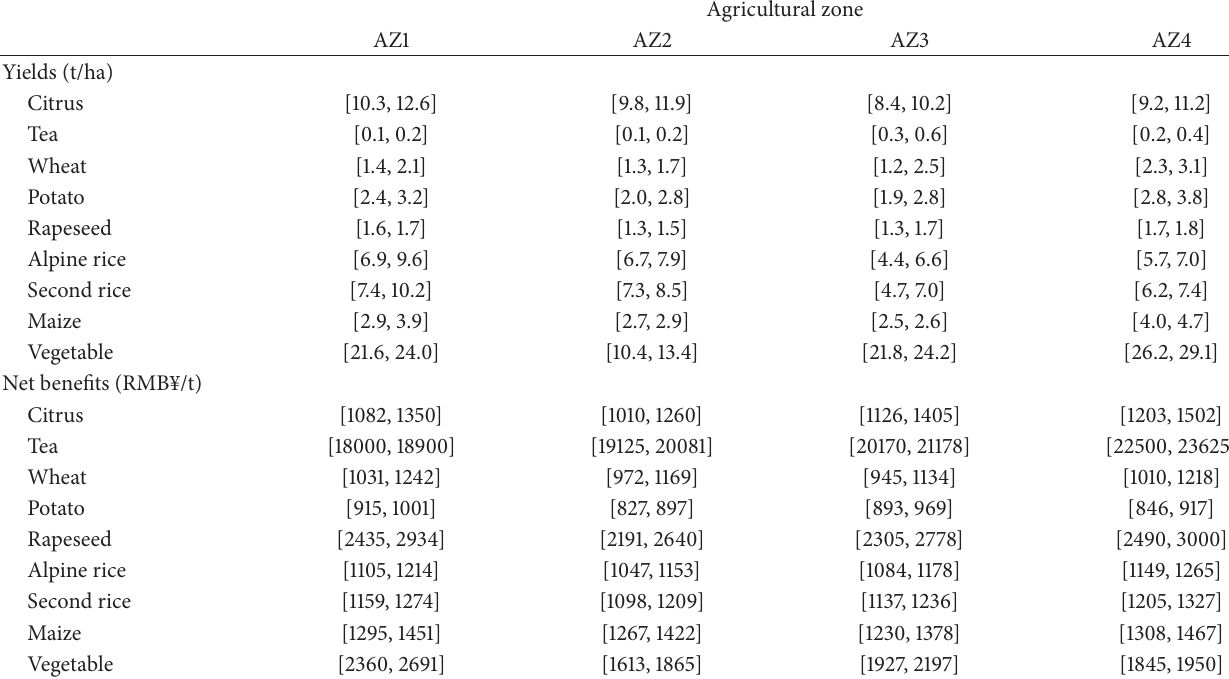
Table 2: Crop yields and net